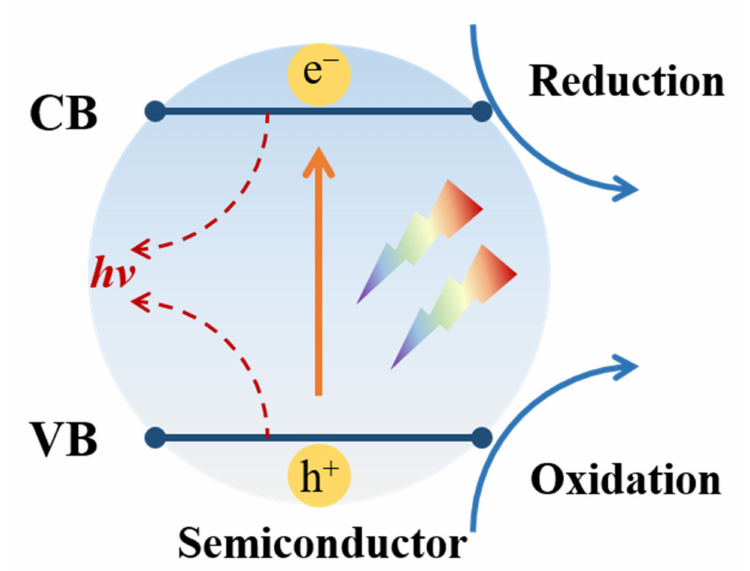
Figure 1. The diagram of semiconductor photocatalysis process.